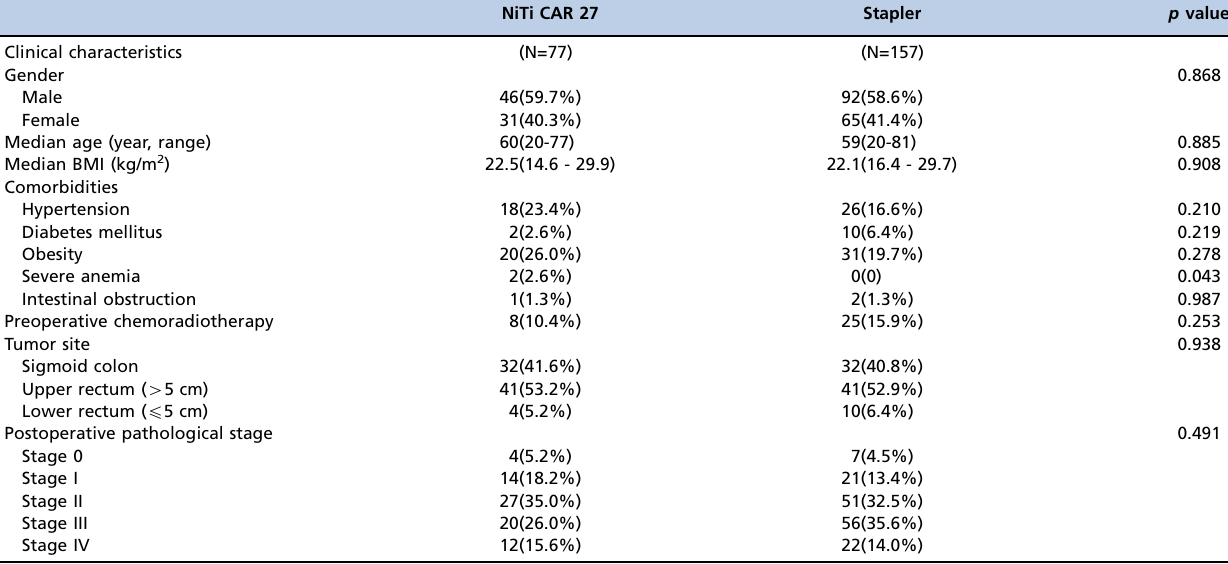
Table 1 - Clinical characteristics of the patients in the NiTi CAR 27 and stapler